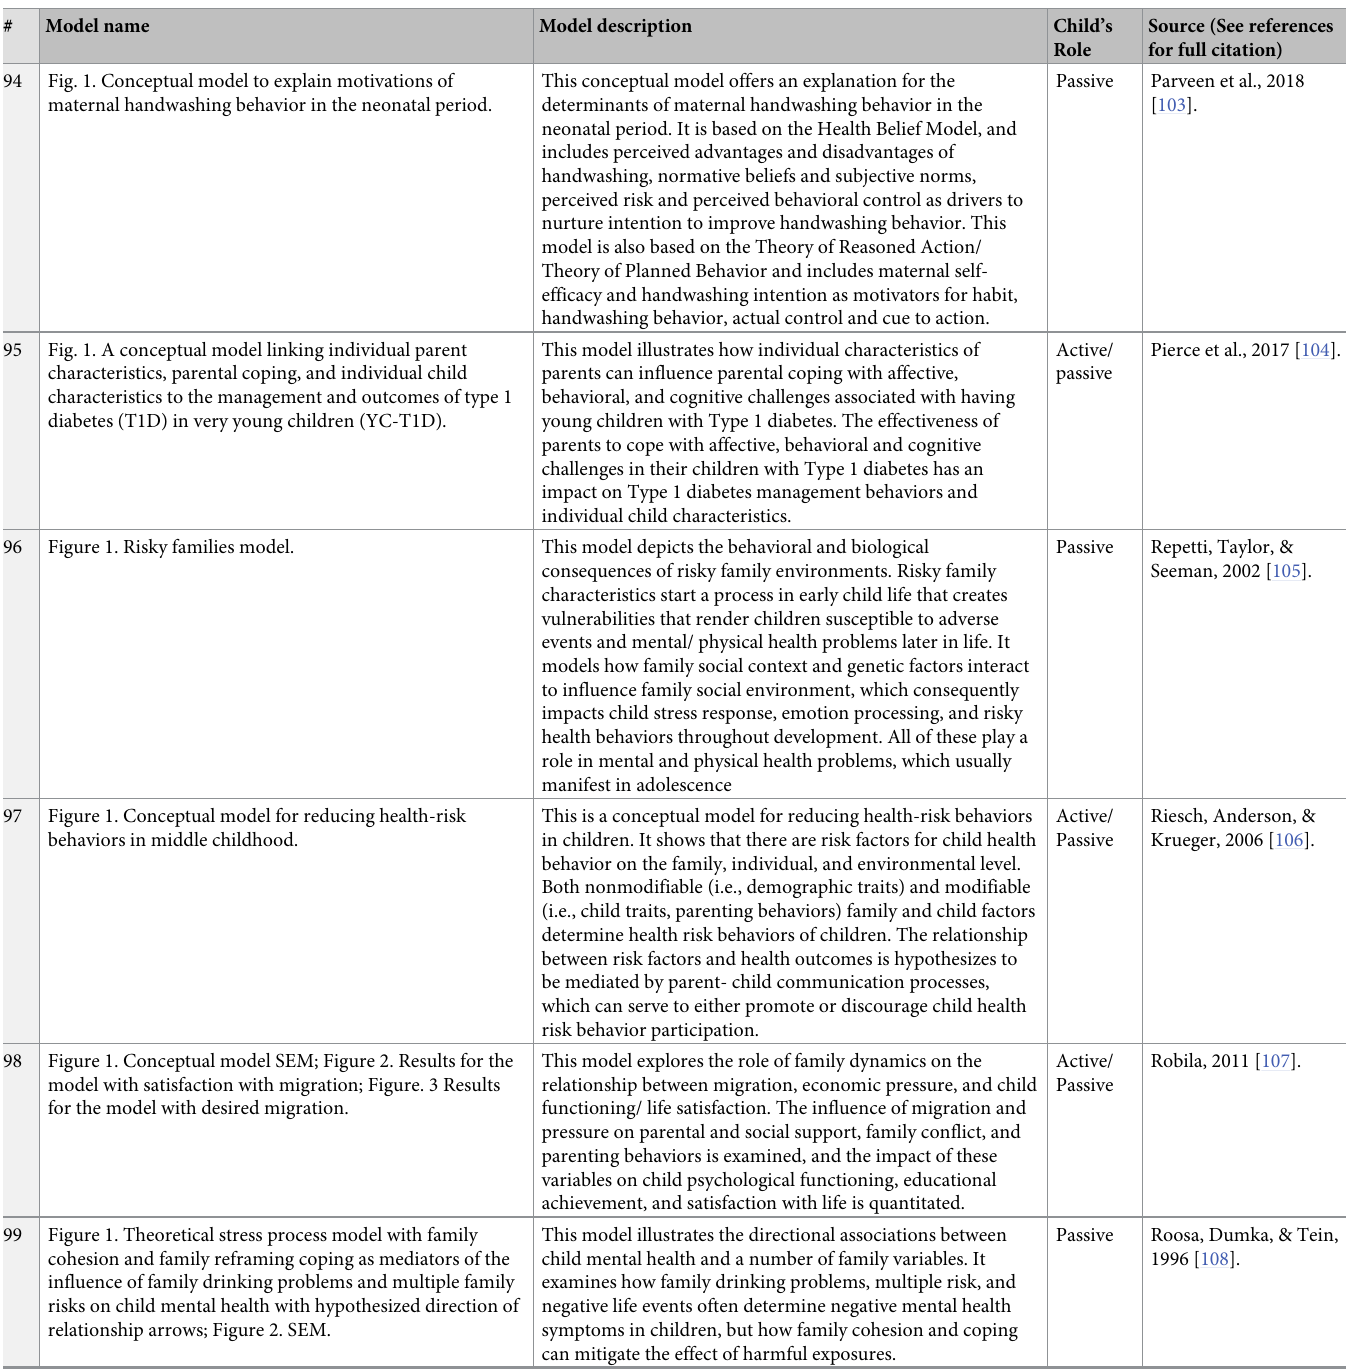
Fig. 1. Conceptual model to explain motivations of maternal handwashing behavior in the neonatal period.